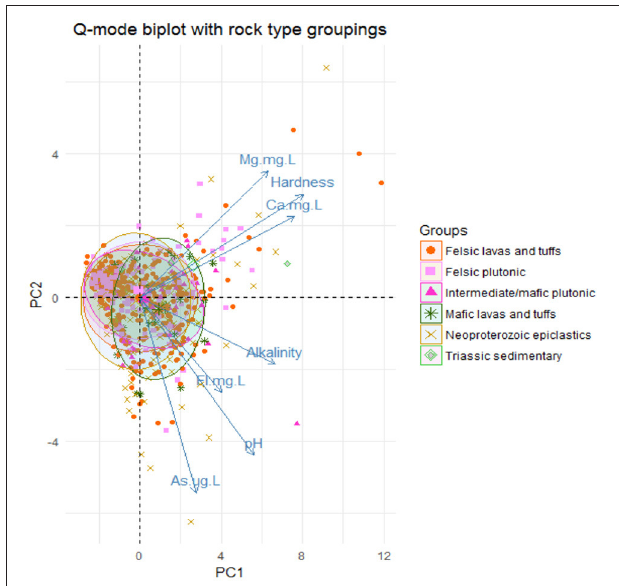
FIGURE 5 | Q-mode PCA analysis biplot of the 1st two principal components. Ellipses were drawn around the points from each rock group encompassing 68% of the points in each group with each ellipse.